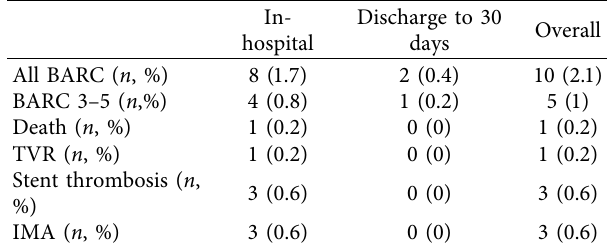
Figure 1: Patterns of administration of tirofiban in study Table 4: In-hospital and 30 days adverse events.